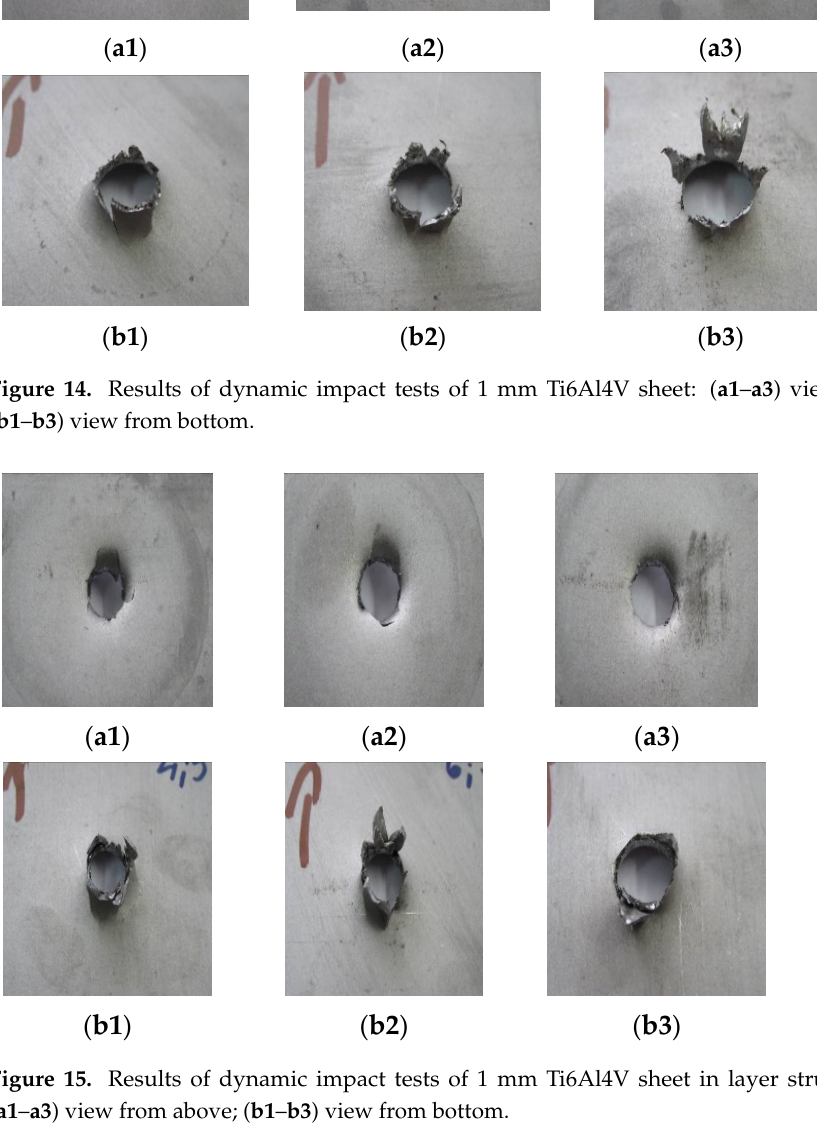
( b3 ) Figure 16. Results of dynamic impact tests of 1 mm Ti6Al4V sheet in layer structure of threes: ( a1 – a3 ) view from above; ( b1 – b3 ) view from bottom. 3.1. Calculation of Specific Energy Absorption W EA The energy-consuming structures used in the aerospace industry should be of the lowest possible weight, but also of high strength and stiffness to specific mass ratio. One of the parameters describing the energy consumption is the total impact energy absorp- tion EA (kJ), equivalent to the area under the load–displacement curve calculated up to points P 1 , P 2 , and P 3 of the sudden curve fall (Figure 11a). In order for energy-absorbing structures to best absorb the impact energy, the de- struction of these structures must not be carried out in an abrupt manner, as in beam dam- age during global buckling. Instead, the destruction should be carried out progressively, so that each volume of the specimen is crushed (destroyed) into the smallest particles. The process of progressive destruction depends mainly on the mechanical properties of the material, its structure, shape, and the geometry of the specimens. The specific energy absorption capability (4) W EA of a composite material is defined as the energy absorbed per unit mass of material as